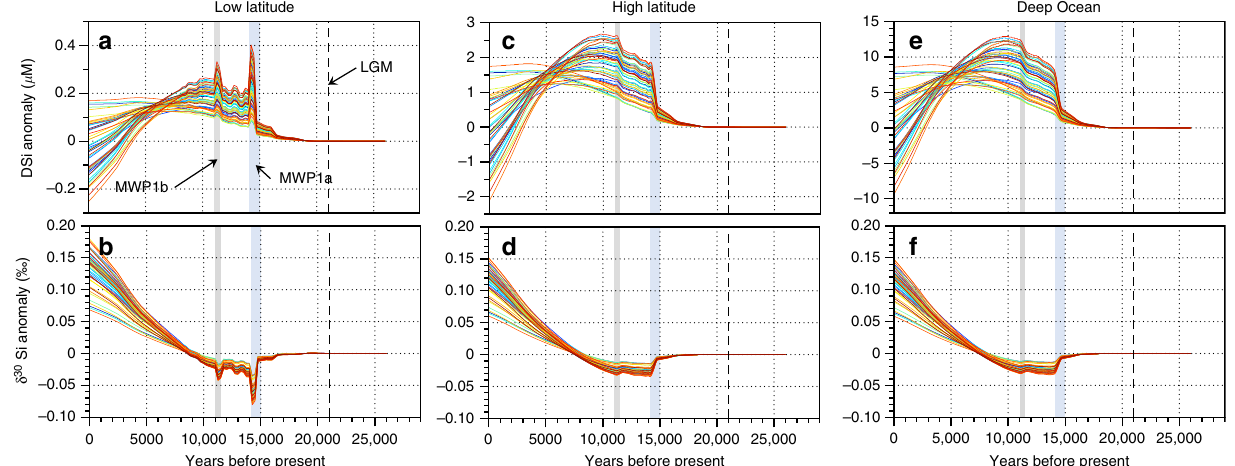
Fig. 5 Modelled impact of glacial to interglacial ice sheet wastage on the oceanic Si cycle. a , b Re fl ect low-latitude surface results for DSi concentrations and δ 30 DSi anomalies, respectively, c , d re fl ect high latitude (i.e. Southern Ocean) DSi concentration and isotopic composition anomalies, respectively and e , f re fl ect deep ocean DSi concentration and isotopic composition anomalies, respectively. Results were generated from an ensemble of 50 model simulations (coloured lines) to sample uncertainty in input fl uxes and δ 30 Si composition, and burial and export ef fi ciency (Fig. 4). Input variables for glacial (DSi + ASi fl ux and respective δ 30 Si composition), nonglacial (DSi + ASi fl ux and respective δ 30 Si composition), export ef fi ciency to depth and burial ef fi ciency in sediments were chosen using a Latin Hypercube. Each simulation was run from a Last Glacial Maximum (LGM) baseline, which was a 100,000-year spin up under LGM conditions (see Methods). Simulations are displayed as anomalies from LGM conditions. The LGM is highlighted by a dashed line, Meltwater Pulse 1a (MWP1a) by the shaded blue region, and Meltwater Pulse 1b (MWP1b) by the shaded grey region. Transient model inputs are displayed in Fig. 4 and Supplementary Table